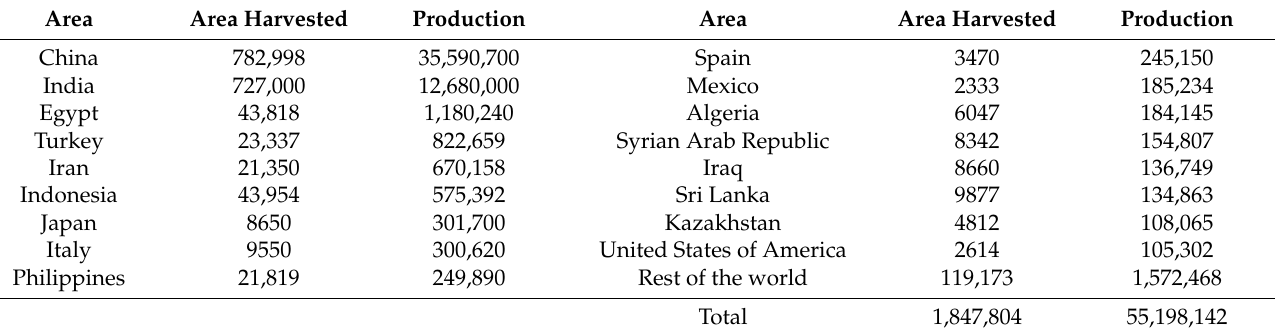
Figure 1. Harvested areas (hectares) and production (tonnes) of eggplant, potato, and tomato in 2019. Source: [13]. Table 1. Production and area of eggplant in the world (2019).